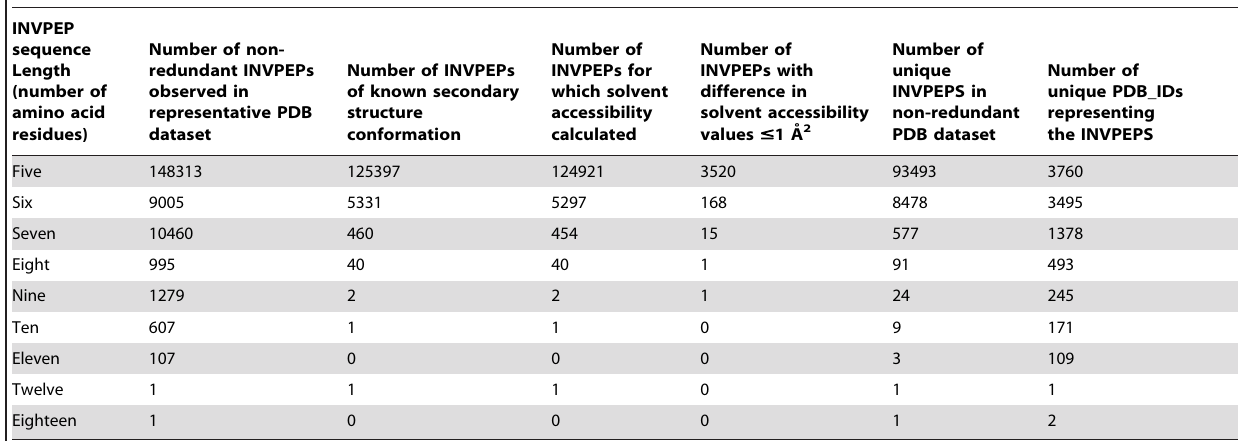
Table 1. INVPEPs in 3967 representative protein chains from the Protein Data Bank (PDB).